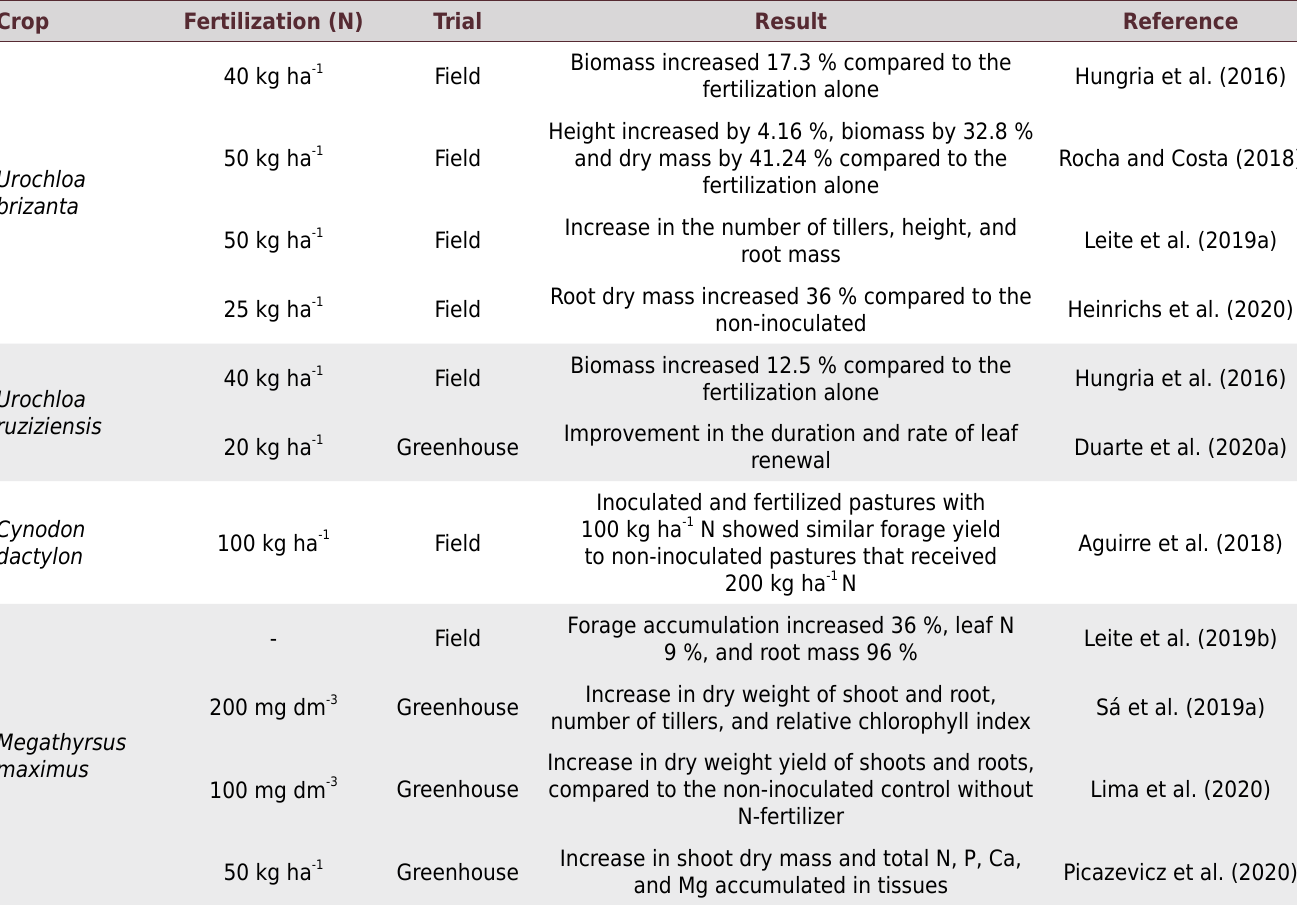
Table 2. Studies reporting benefits of inoculation with Azospirillum brasilense strains Ab-V5 and Ab-V6 in pastures in Brazil